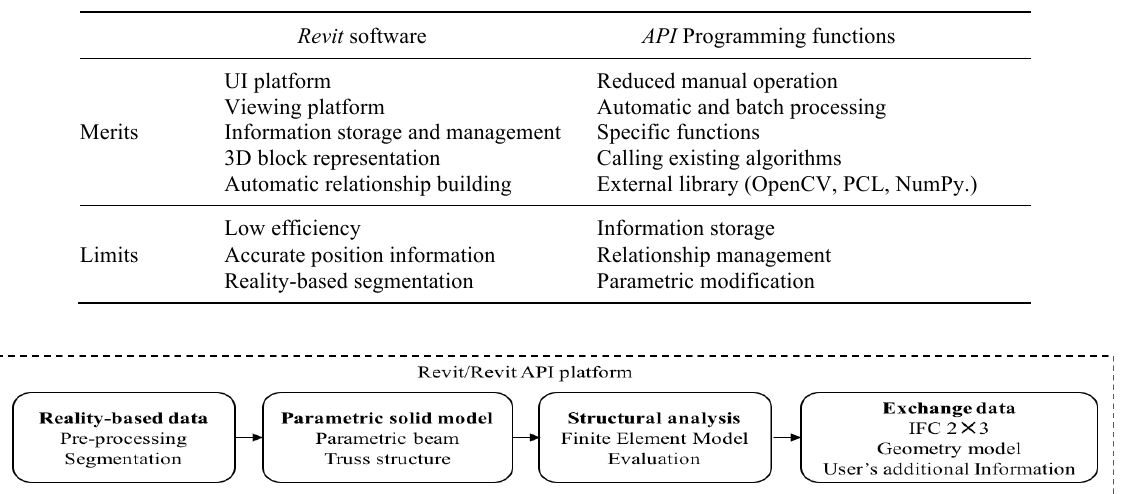
Table 1. Revit API development